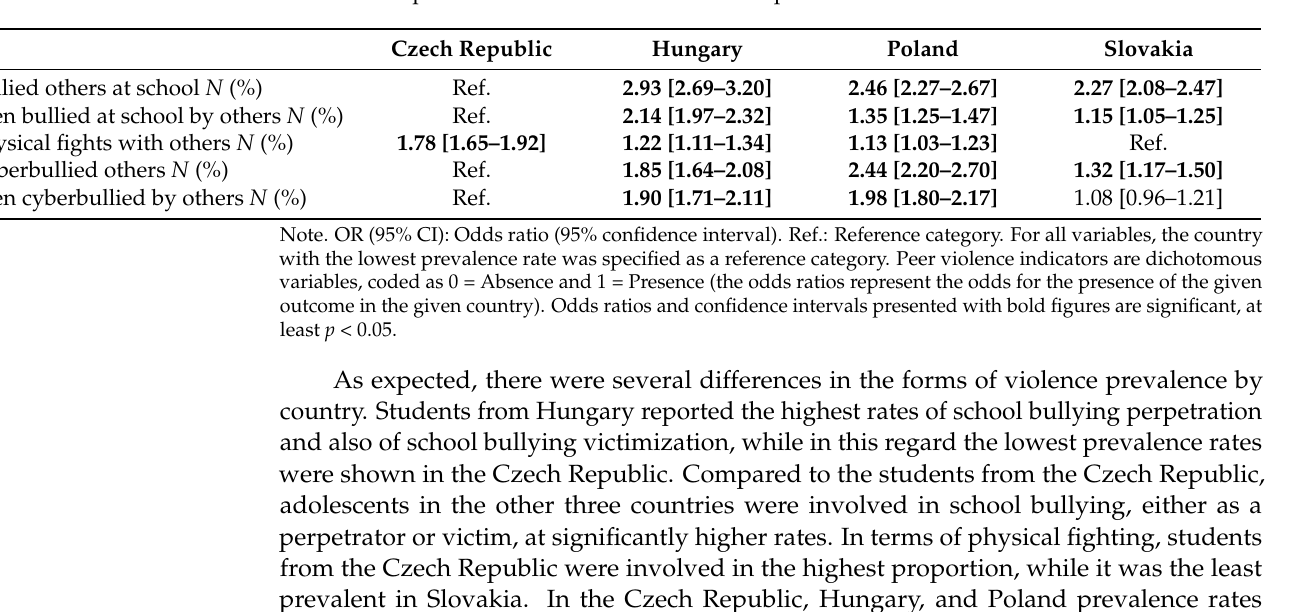
Table 3. Comparisons of the countries in terms of peer violence